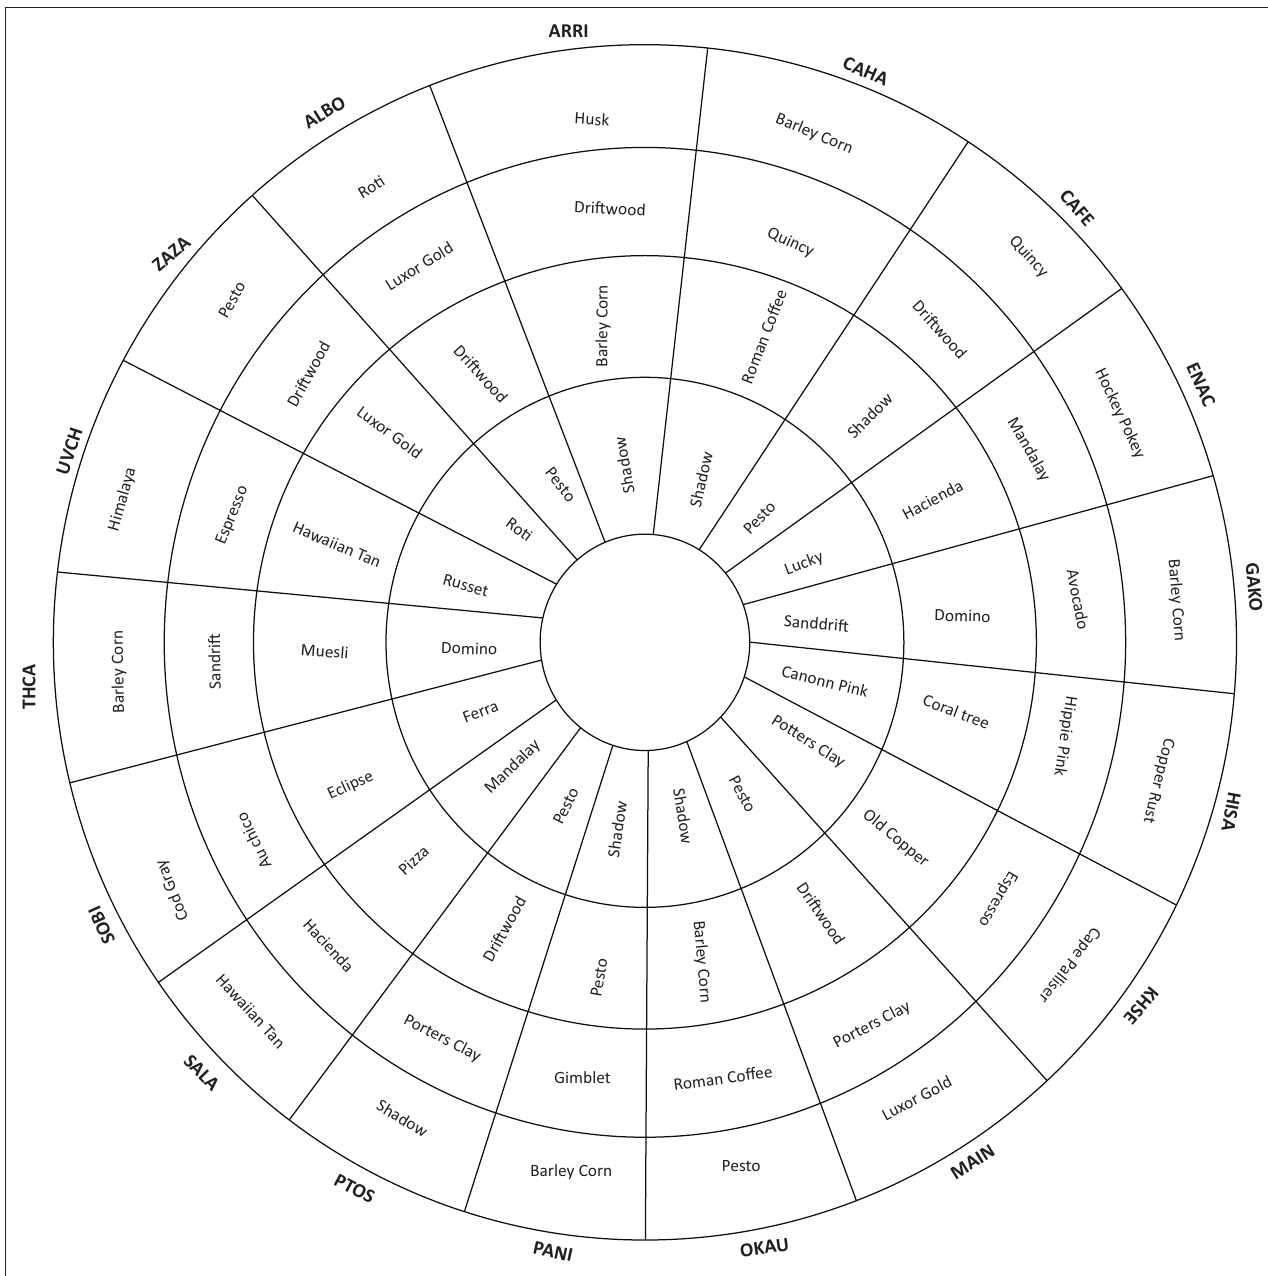
FIGURE 2: Diagnostic Hypertext Preprocessor colour chart for the powdered herbs studied. Colours in the innermost ring of boxes represent the typical colours (i.e. of the highest relative intensity value); those in the second ring represent the colours with the second highest intensity value; those in the third ring represent the colours with the third highest intensity value, while those in the outermost ring represent the colours with the fourth highest intensity